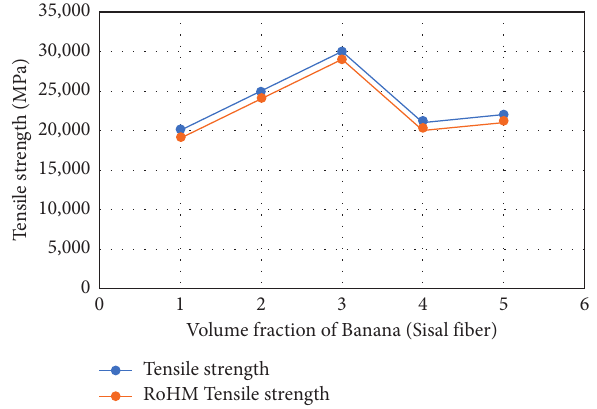
Figure 2: Experimental and RoHM tensile strength of banana/sisal fiber composites results.